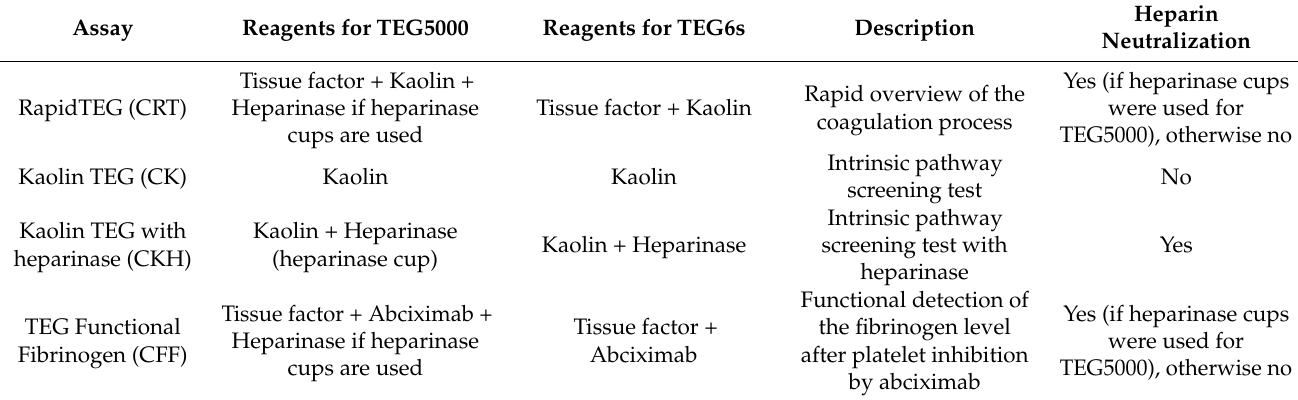
Table A3. TEG®reagents.